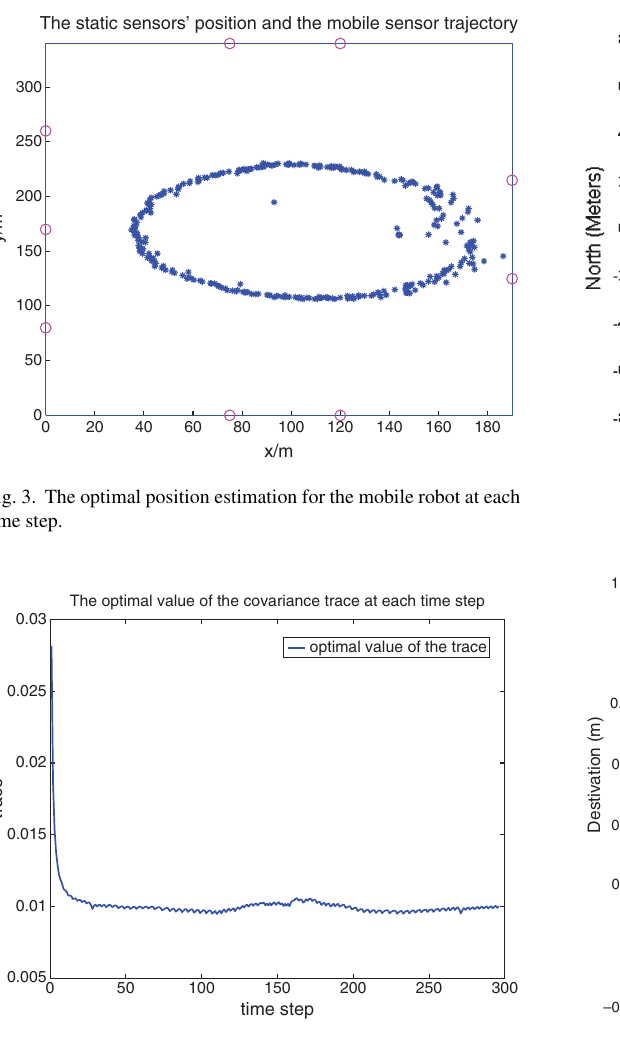
Fig. 4. The optimal value of the covariance trace.